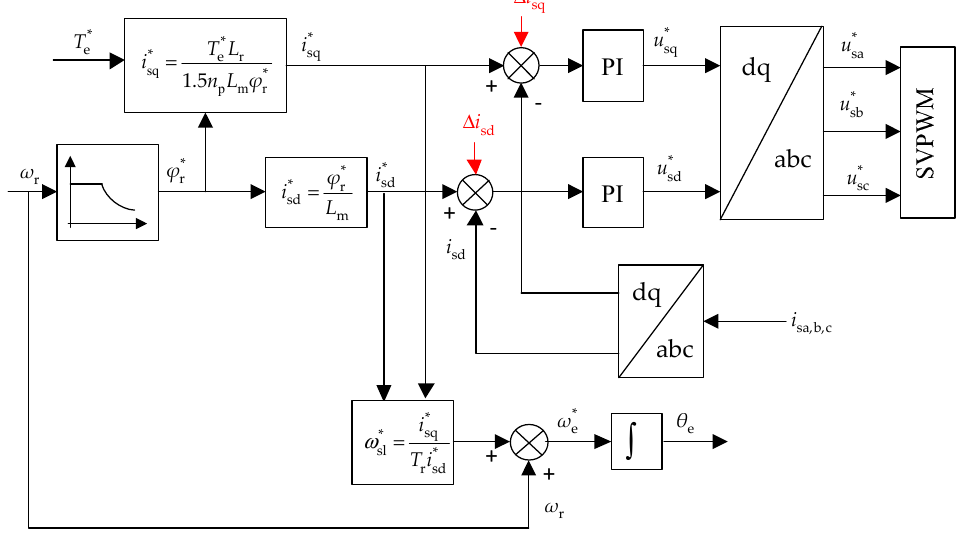
Figure 8. Closed-loop control structure of the motor drive system with the injection of equivalent sinusoidal currents in the current references for online parameter identification.